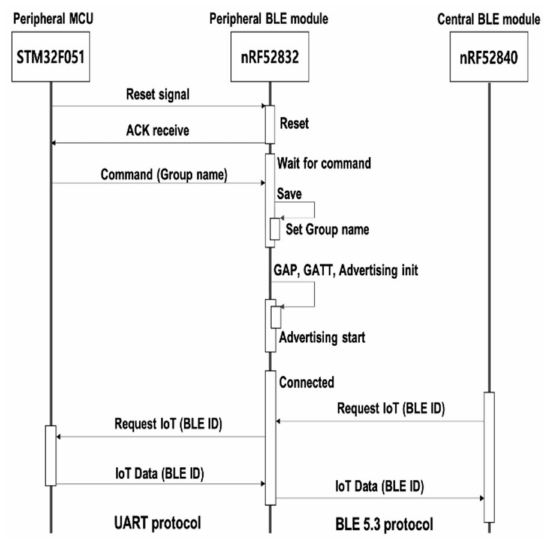
Figure 8. Sequence diagram of peripheral